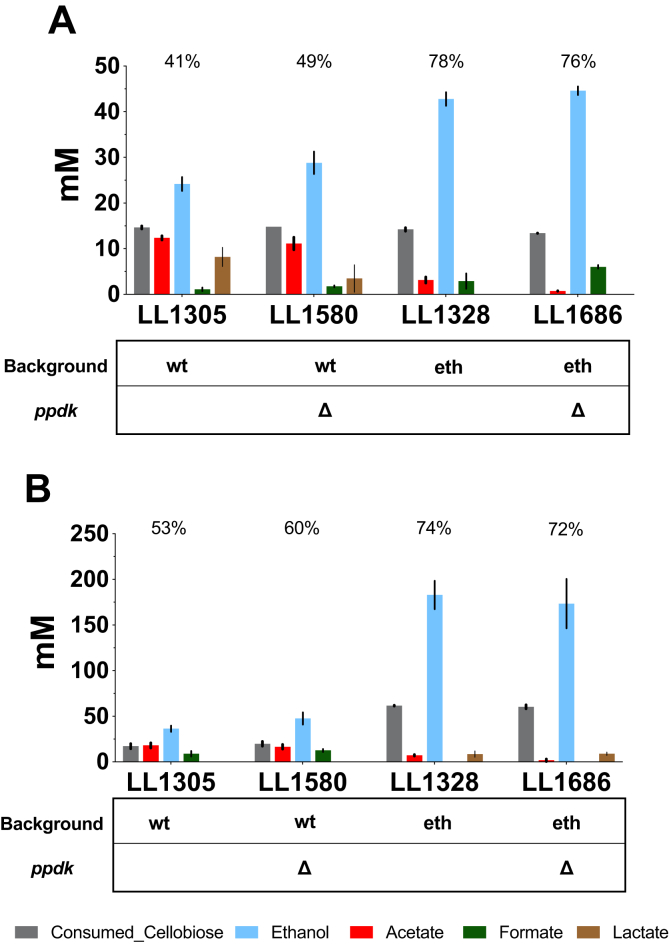
Fermentation result of T. saccharolyticum ppdk deletion strains. Data was collected from 72-h batch fermentations in MTC-6 medium containing 5 ​g/L (A) or 20 ​g/L (B) initial cellobiose. The number above the ethanol bar indicates ethanol yield, as a percentage of the theoretical maximum, which is 4 ​mol of ethanol per mole of cellobiose. wt stands for wild type background, eth stands for homoethanologen background. Error bars represent one standard deviation from three replicates.